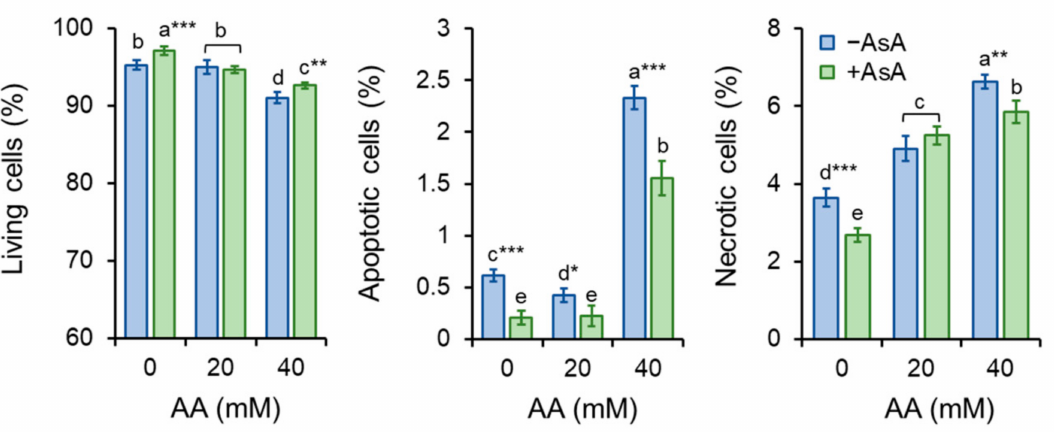
Figure 7. Yeast cell apoptosis determination. To evaluate cell death by apoptosis, Annexin V-FITC signal was determined upon AA exposure of cells un- and pre-treated with AsA. Cells were co-stained with PI to distinguish between apoptosis and necrosis. PI positive cells were considered necrotic. Bars represent mean ± SD of at least 150 counted cells. Statistical significance is determined by Duncan’s post-hoc test, different letters above bars indicate statistical difference. Significance of statistical differences are indicated as p < 0.05 *, 0.01 **, 0.001